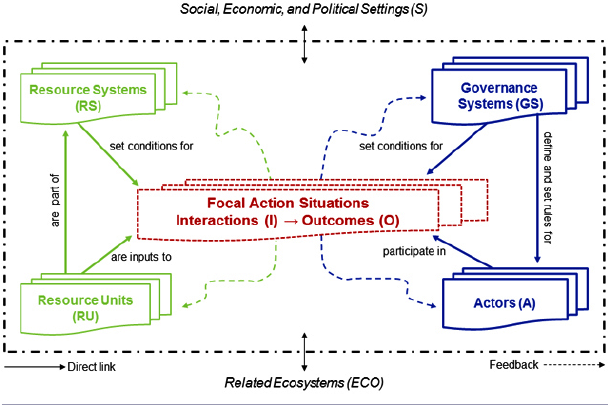
Fig. 1. Conceptualization of the social-ecological systems framework from McGinnis and Ostrom (2014). First-tier variables are shown with their interactions and